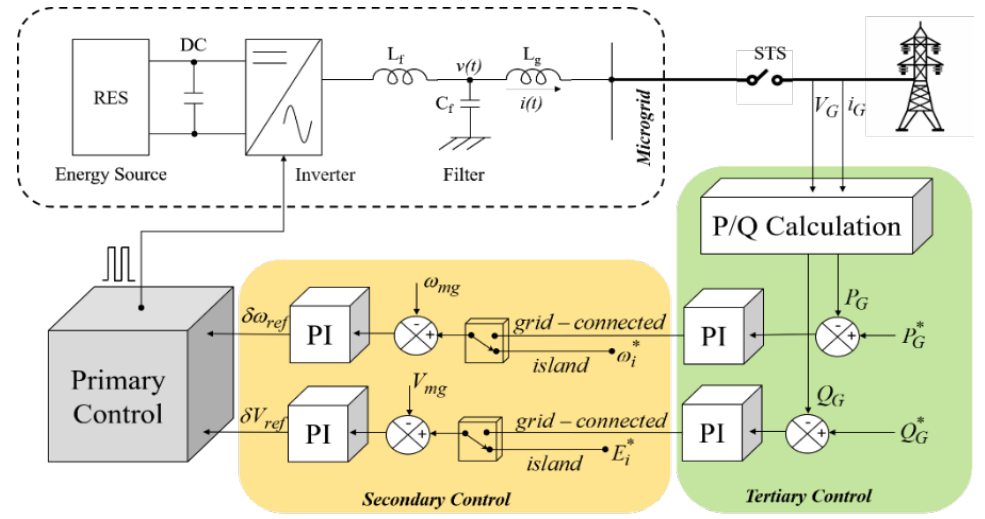
Figure 4. Standard structure’s block diagram consisting of secondary and tertiary controls.